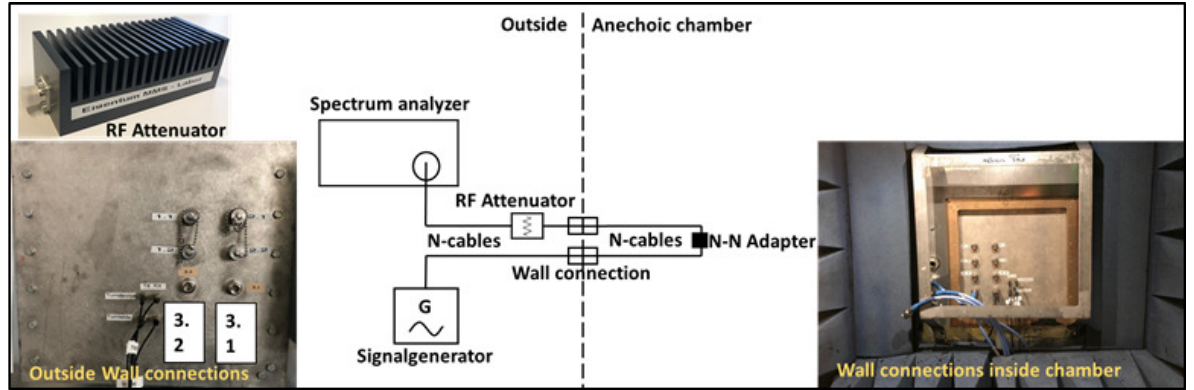
Figure 3. Network loss measurement